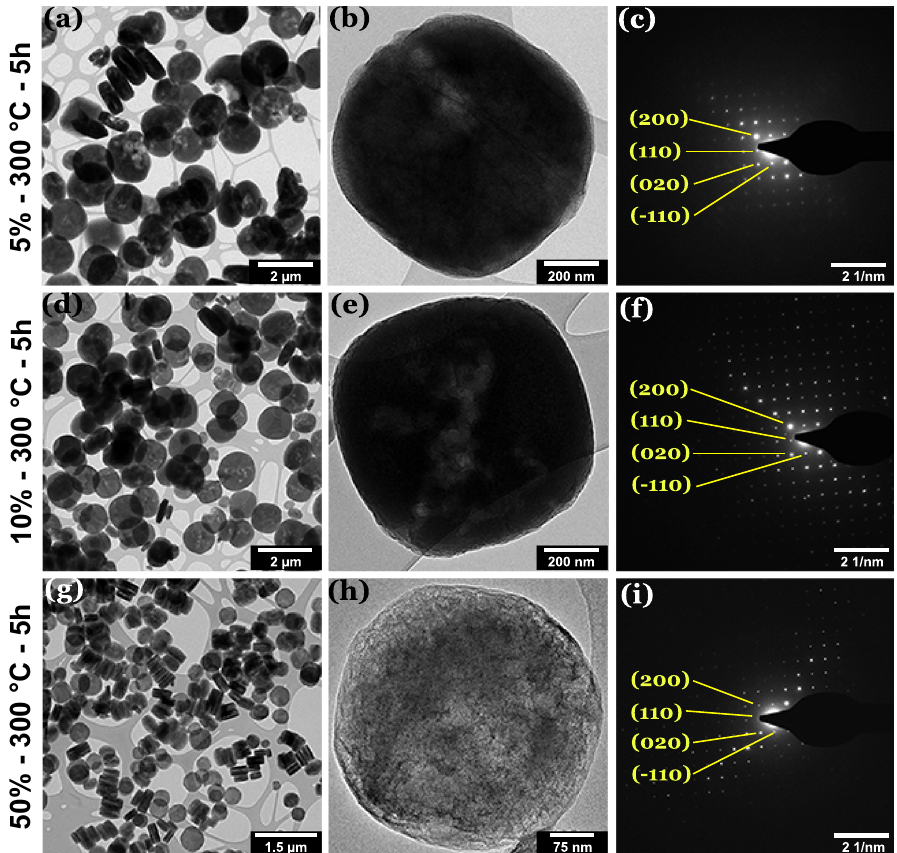
Fig. 3 TEM/SAED analysis of MOFs heated at 300 °C for 5 h. a – c BF-TEM images of 5%NH 2 -MIL as an overview ( a ) and of an individual MOF particle ( b ) along with the corresponding SAED pattern ( c ). d – f and g – i show the corresponding BF TEM and SAED data for the 10% and 50%NH 2 -MIL, respectively. All SAED patterns have been indexed using the cif fi le and fi t the MIL-125-Ti structure, 30 viewed along the [001] zone axis. No indications of other phases were detected in the SAED